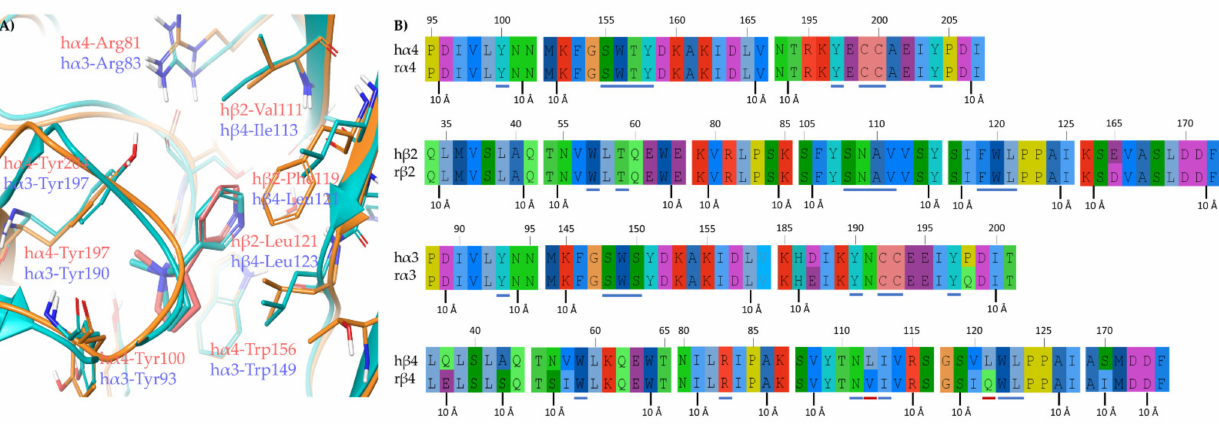
Figure 3. ( A ) Superimposition of the h α 4 β 2 and h α 3 β 4 binding sites complexed with ( S )- nicotine (orange residues, backbone cartoons, and red ligand for h α 4 β 2 and light blue residues, backbone cartoons, and ligand for h α 3 β 4) extracted from the cryo-EMs 6CNJ and 6PV7, respectively. ( B ) Extracts of alignments of human and rat α 4, β 2, α 3, and β 4. Residues within 5 Å from the ligand has been underlined in blue, when identical between the species, in red when different.